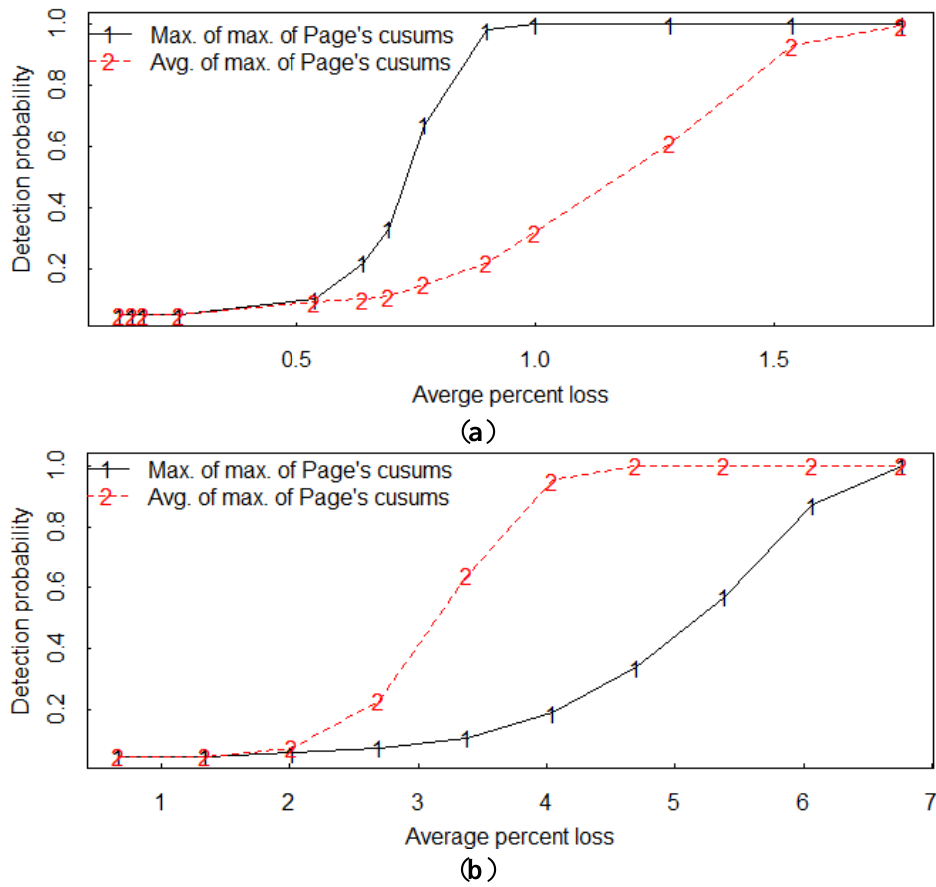
Figure 11. Example estimated detection probabilities versus the average percent loss in a ( a ) local loss from the input and in a ( b ) non-local (widespread) loss from all 13 residual streams. The average is over all 13 residual streams during the one-time-step duration of the